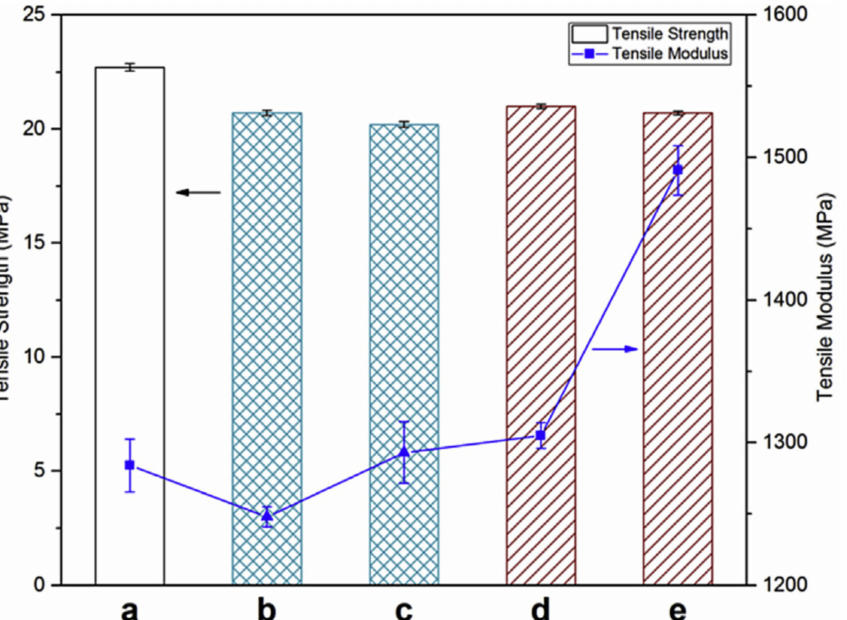
Figure 5. The tensile properties of biochar filled composites, ( a ) neat polymer, ( b , c ) LtBioC filled composites and ( d , e ) HtBioC filled composites. The tensile properties of composites filled with HtBioC were shown to be better than neat polymer and composites filled with LtBioC. Figure is taken from [36] with permission to reuse from Elsevier publications